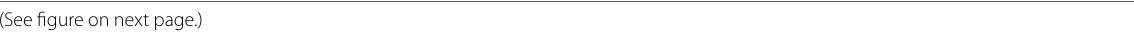
et al. (1973), the layer at a depth of 6 km (SEB) to 10 km (NWB) may represent a volcanic basement or metasedi- ments. The gravity zone associated with the NEB has a deep basement rock (north: 9 to 11 km, south: 7 to 9 km)